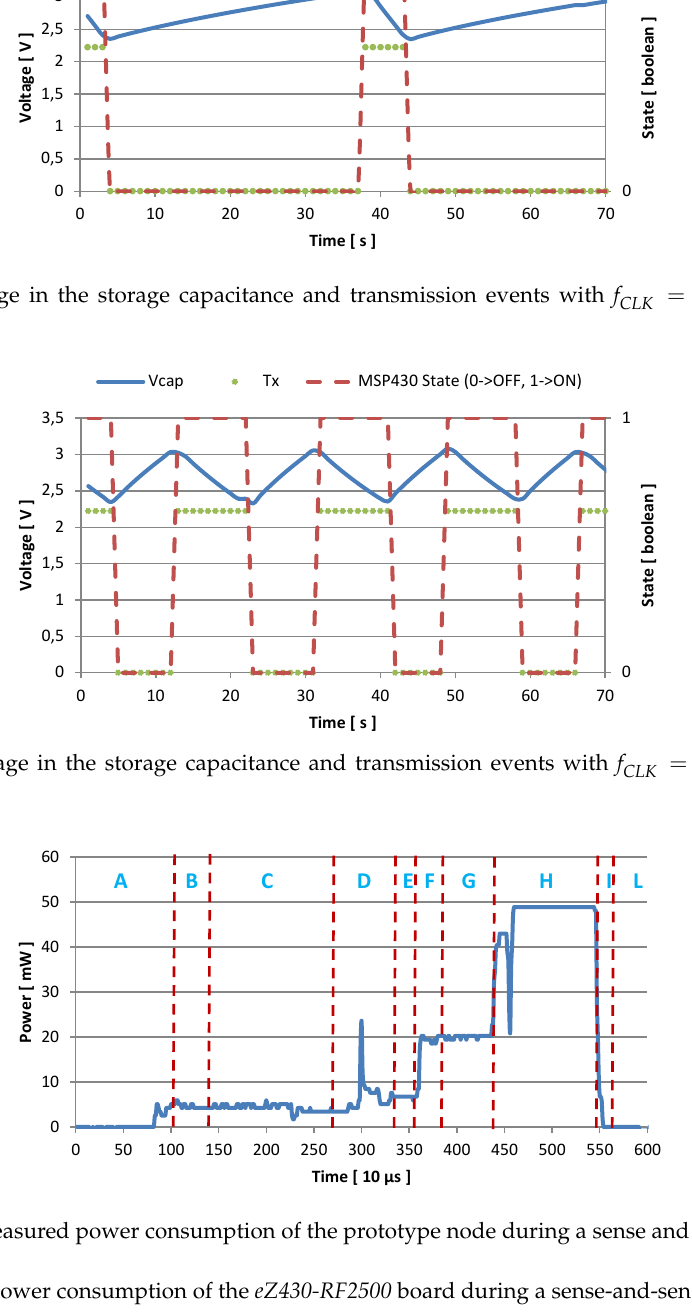
= 1.2 GHz, and CLK